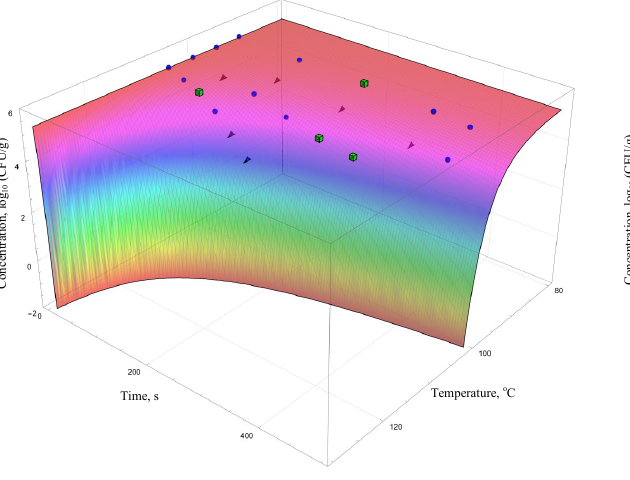
Figure 8 Secondary nonlinear models of microbial death of A. acidoterrestris during heat treatment